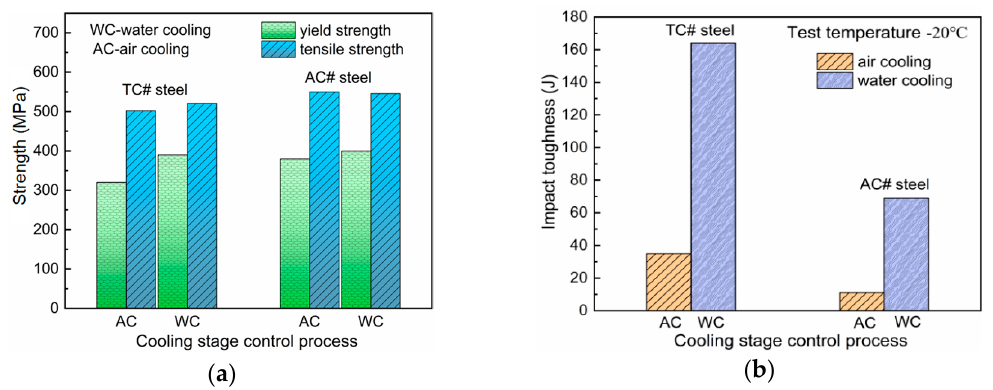
Figure 8. ( a ) Tensile and ( b ) impact properties of hot-rolled steel plates with different cooling Figure 8. (a) Tensile and (b) impact properties of hot-rolled steel plates with different cooling conditions.